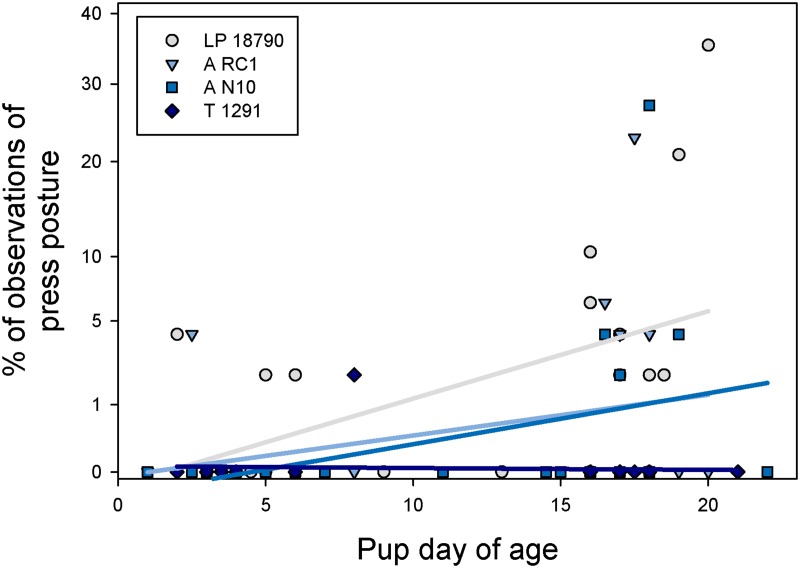
Proportion of press posture observed at different pup ages in the four cage sizes.Data points are plotted with the least squares line.